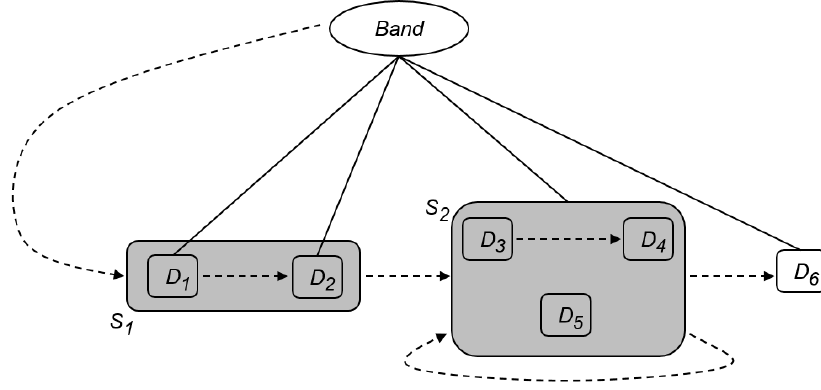
Figure 18. The object life model of a band. Source: